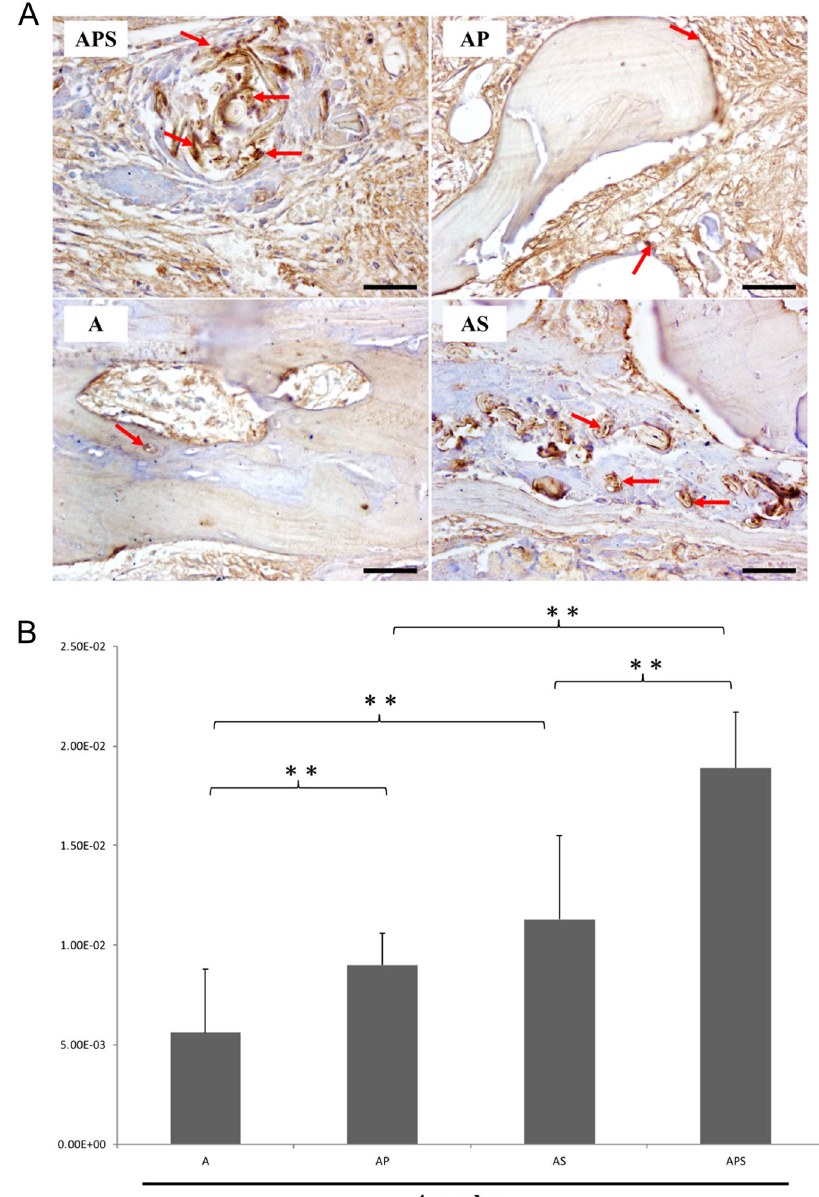
Fig. 5 A Immunohistochemical detection of CD34 revealing neovascularization in the A, AP, AS, and APS groups at 4 weeks. Original magni fi cation, ×400. Arrow, nascent blood vessels. Bar size, 50 μ m. B Quantitative analysis of CD34-dependent vessel density in four groups by the IPP software. * p < 0.05, Fig. 1. Anteroposterior radiographs showing the status of bone regeneration in the four groups. Left, 2 weeks postoperative. Right, 4 weeks postoperative. The upper section is CT 3D reconstruction images, and the lower section is X-ray